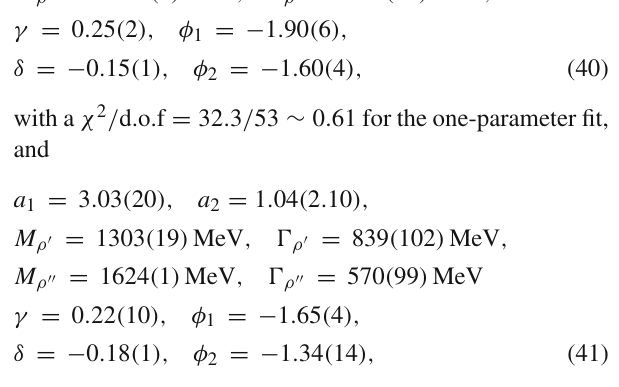
(reference fit) is also displayed by the light red error